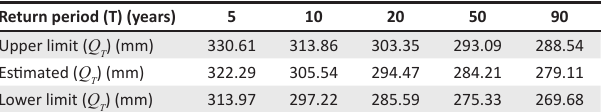
TABLE 8: Q-T results: X3C agricultural drought of maize events in October to December growing period. Return period (T) (years)